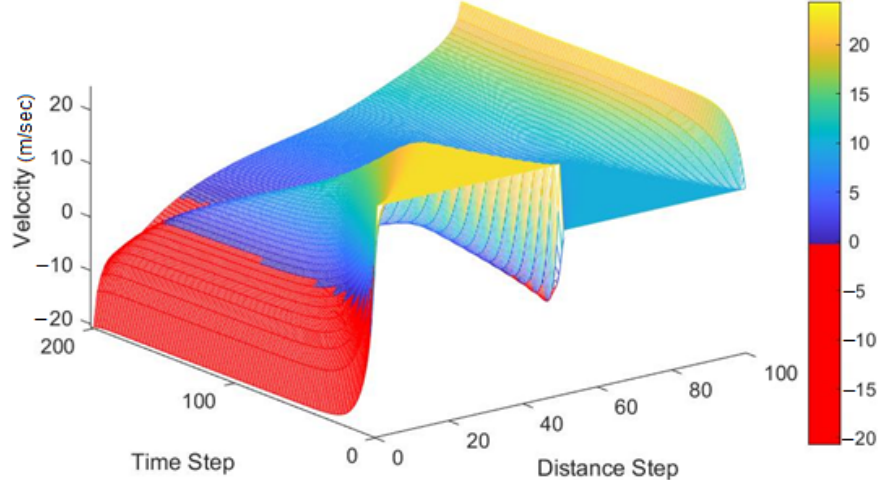
Figure 9. Velocity behavior of PW model on straight road with no ingress traffic.